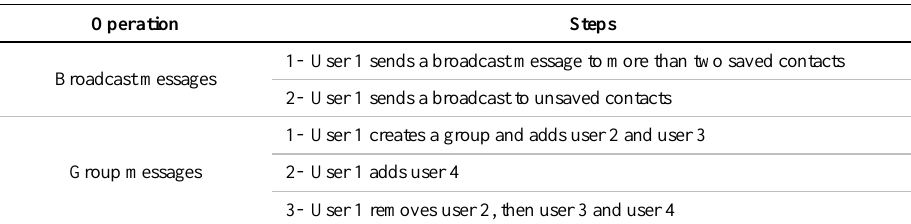
Table 4. Broadcast and group message